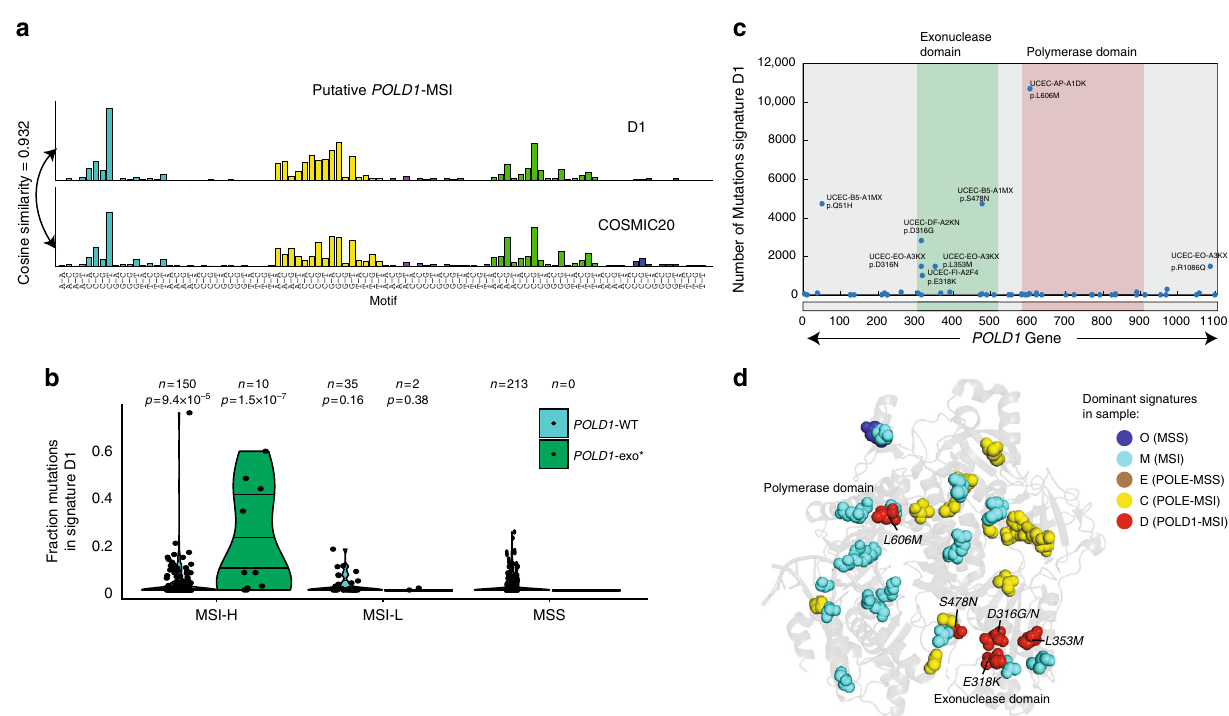
Fig. 4 A distinct mutational signature is associated with paired loss of POLD1 proofreading and MMR. a The 96 trinucleotide mutational spectrum of signature D1 and comparison to COSMIC signature 20. b The fraction of mutations assigned to signature D1 across the cohort, segregated by POLD1-exo* and MSI status. The distribution of each group is compared to that of polymerase wild-type MSS samples using a one-tailed rank-sum test. c Association of signature D1 with mutations in POLD1 . d Location of POLD1 mutations mapped to the corresponding location on the yeast POLD1 homolog (PDB ID: 3IAY). Amino acids are color coded by the dominant mutational signature in the sample